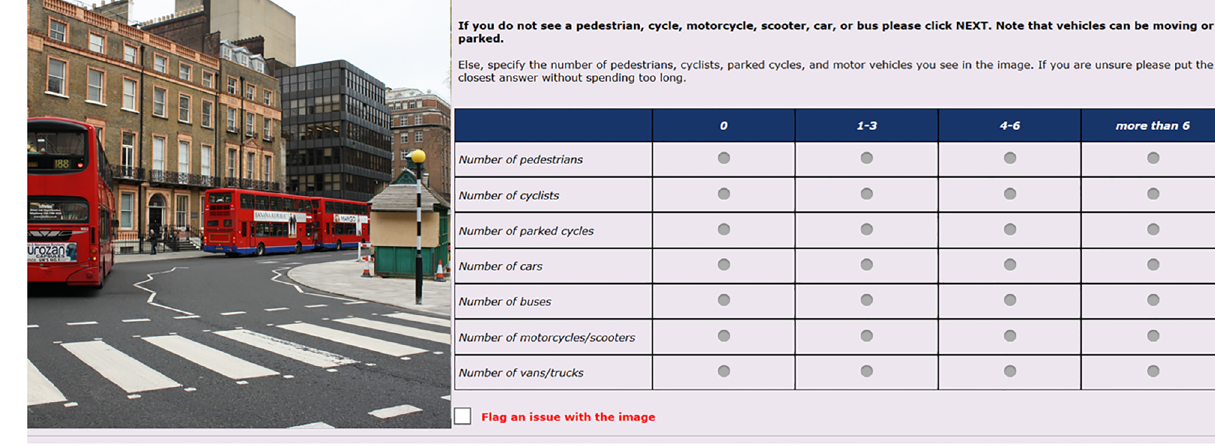
Fig 1. Snapshot of the web-based questionnaire (image is illustrative and not from GSV to comply with copyright issues).